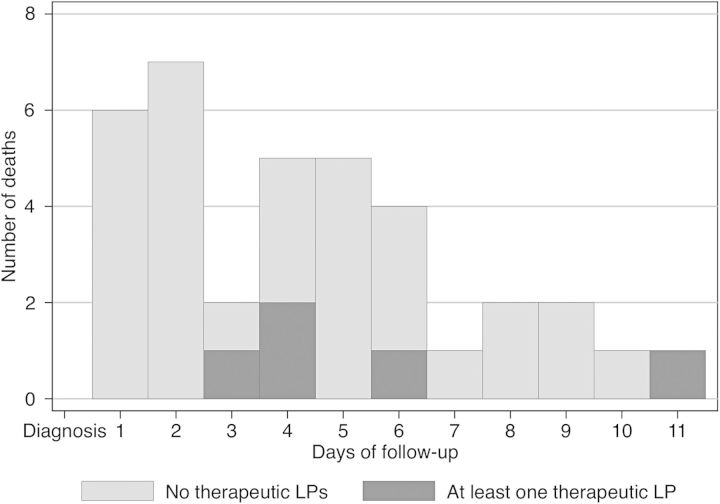
Distribution of time to death among those with and without at least 1 therapeutic LP among HIV-infected individuals with cryptococcal meningitis in South Africa and Uganda. A total of 36 deaths occurred within 11 days after diagnosis with cryptococcal meningitis. The overall median time to death was 4 days after diagnosis. Abbreviations: HIV, human immunodeficiency virus; LP, lumbar puncture.